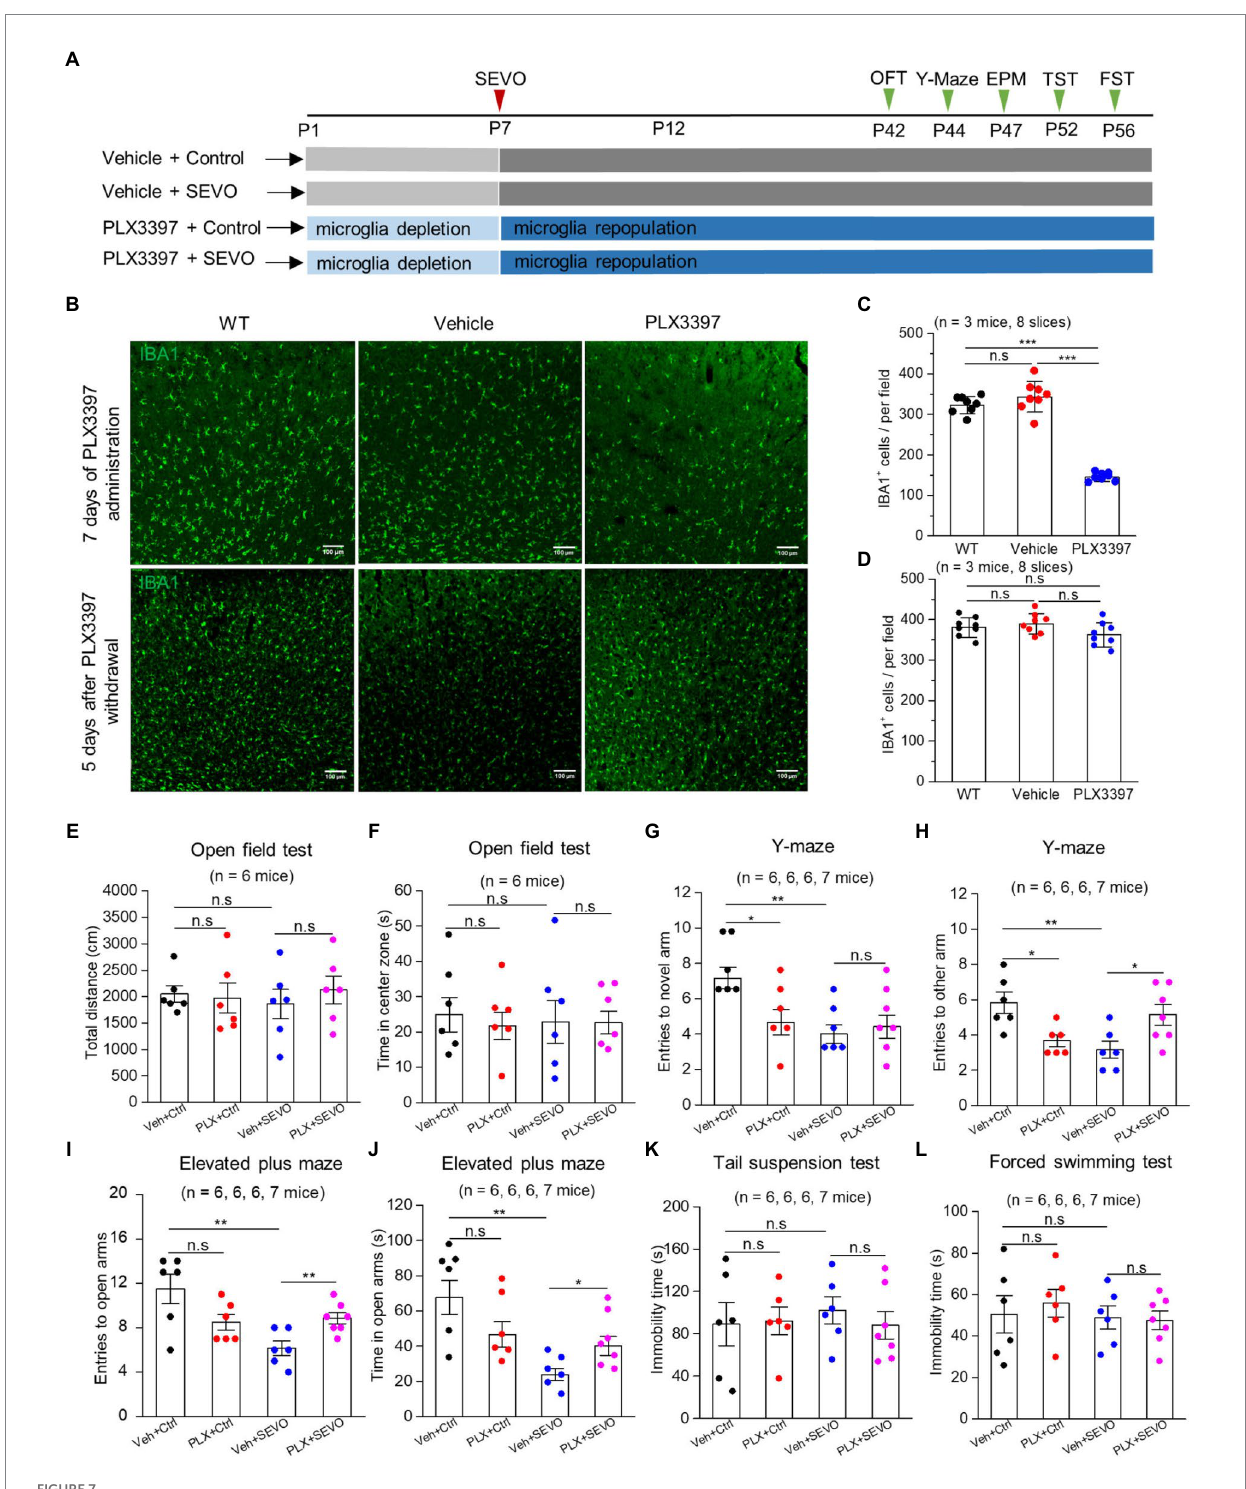
FIGURE 7 Microglia depletion before sevoflurane exposure and later neurobehavioral experiments in adult mice. (A) Flow chart of microglia depletion by PLX3397 before sevoflurane exposure and neurobehavioral experiments in adult mice. (B) Representative images of IBA1 expression in the somatosensory cortex after 7 days of PLX3397 administration (above), and 5 days after PLX3397 withdrawal (below). (C) Quantification of the number of IBA1 + cells after 7 days of PLX3397 administration (WT vs. Veh: p = 0.211; WT vs. PLX: p < 0.001; Veh vs. PLX: p < 0.001, one-way ANOVA test). (D) Quantification of the number of IBA1 + cells 5 days after PLX3397 withdrawal (WT vs. Veh: p = 0.489; WT vs. PLX: p = 0.204; Veh vs. PLX: p = 0.073, one-way ANOVA test). (E) Quantification of total distance in the open field test (Veh + Ctrl vs. PLX + Ctrl: p = 0.822; Veh + Ctrl vs. Veh + SEVO: p = 0.566; Veh + SEVO vs. PLX + SEVO: p = 0.504, one-way ANOVA test). (F) Quantification of time in the center zone in the open field test (Veh + Ctrl vs. PLX + Ctrl: p = 0.623; Veh + Ctrl vs. Veh + SEVO: p = 0.803; Veh + SEVO vs. PLX + SEVO: p = 0.971, one-way ANOVA test). (G) Quantification of entries to novel arm in the Y-maze test (Veh + Ctrl vs. PLX + Ctrl: p = 0.023; Veh + Ctrl vs. Veh + SEVO: p = 0.001; Veh + SEVO vs. PLX + SEVO: p = 0.852, one-way ANOVA test). (H) Quantification of